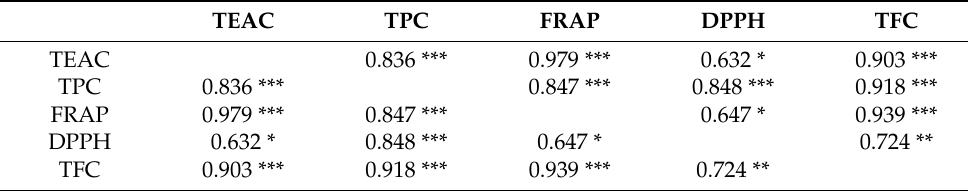
Computed correlation used Pearson-method. Table A2. Correlation matrix for TEAC, TPC, FRAP, DPPH and TFC antioxidant capacity indices of three developing stages of Peumo. Harvest season 2018. Significance level of p -vales < 0.001 (***), 0.01 (**), 0.05 (*).